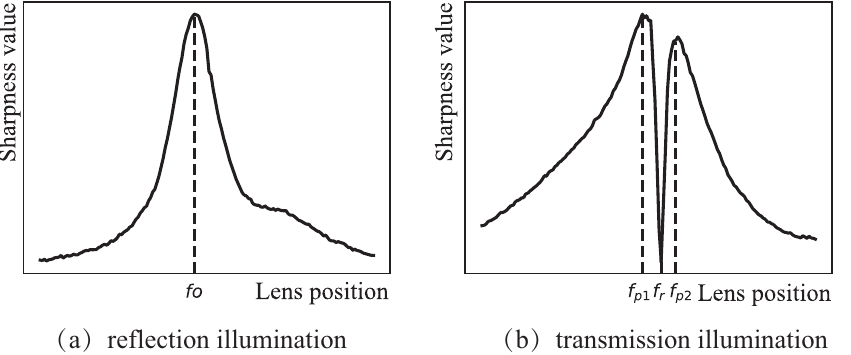
Figure 1. Focus curves under different illumination modes.